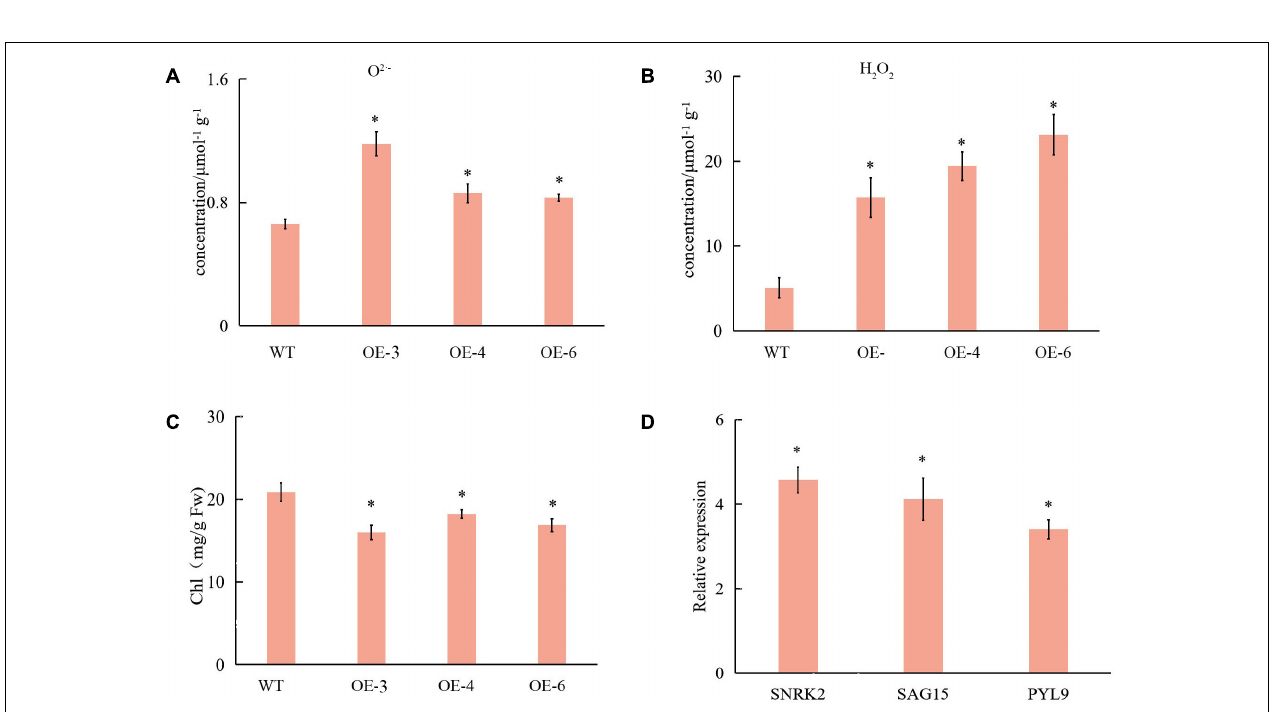
FIGURE 9 | The content of the O 2 ·− (A) and H 2 O 2 (B) in WT and OE plant of 25 days seedlings. Chl content (C) and relative expression of WT and OE plants related with leaf senescence (D) . SNRK 2, sucrose non-fermenting 1-related protein kinase 2; SAG15, senescence-associated gene15; PYL, pyrabactin resistance 9. Relative expression levels of leaves senescence with OE plants compare with control (WT). The experiments were repeated three times. Error bars indicate the means ± SE of three independent replicates. Expression data of WT was normalized to 1. *Significant differences with P < 0.05 determined using a Duncan’s test compared with the